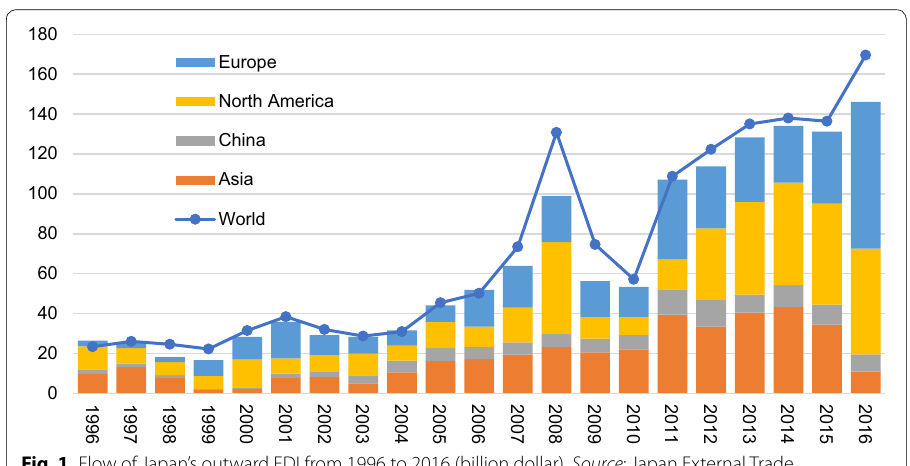
Fig. 1 Flow of Japan’s outward FDI from 1996 to 2016 (billion dollar). Source : Japan External Trade Organization (JETRO)